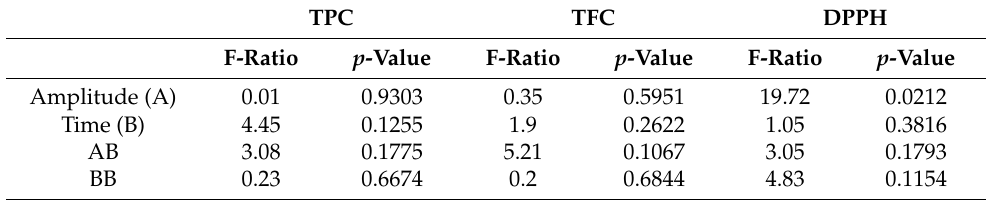
Table 2. Adequacy of the model through the analysis of F-ratio and p -value .